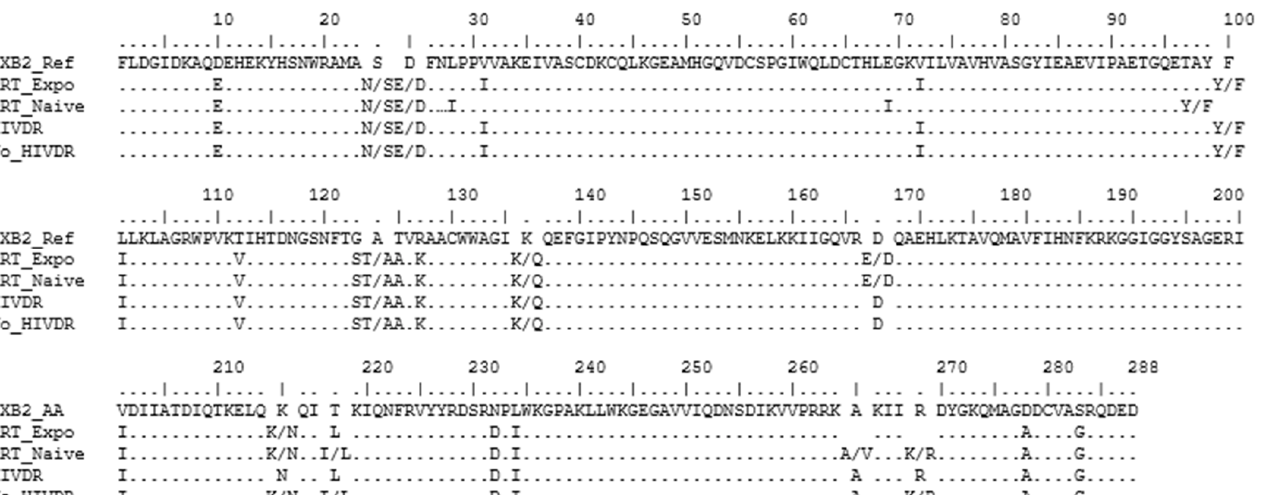
acids at positions T215K/N, T218I/L, and R269R/K, respectively (Figure 3).